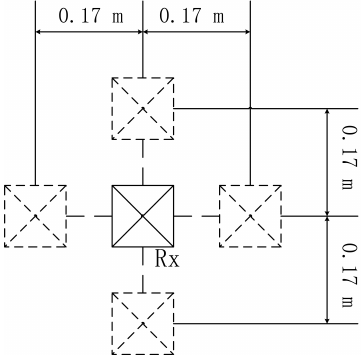
Figure 4. Positions of RX (receiver side) at each